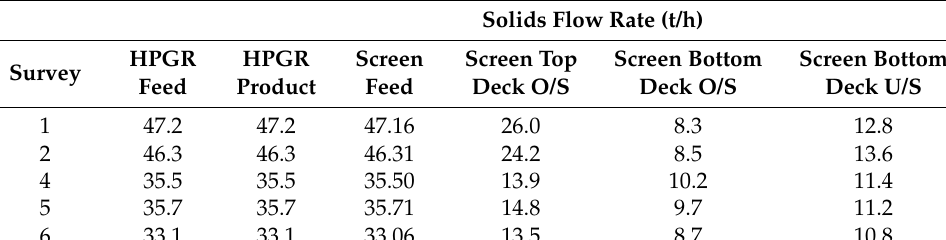
Table 4. Mass balance results — solids flow rate.